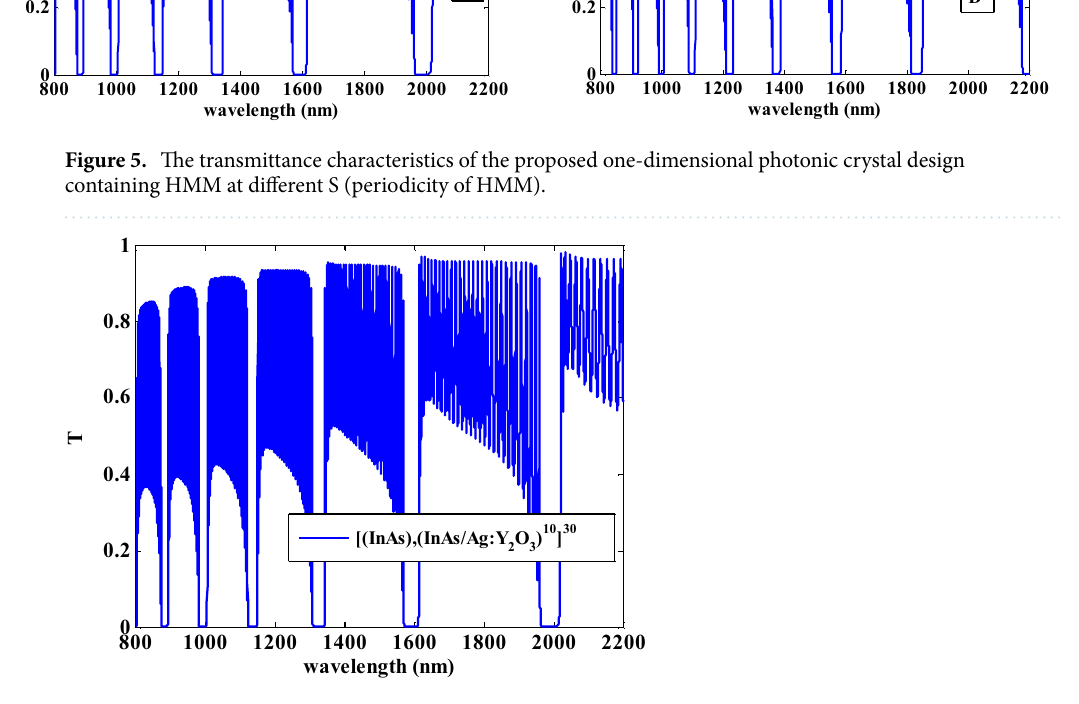
Figure 6. The transmittance spectra of the proposed one-dimensional photonic crystal containing